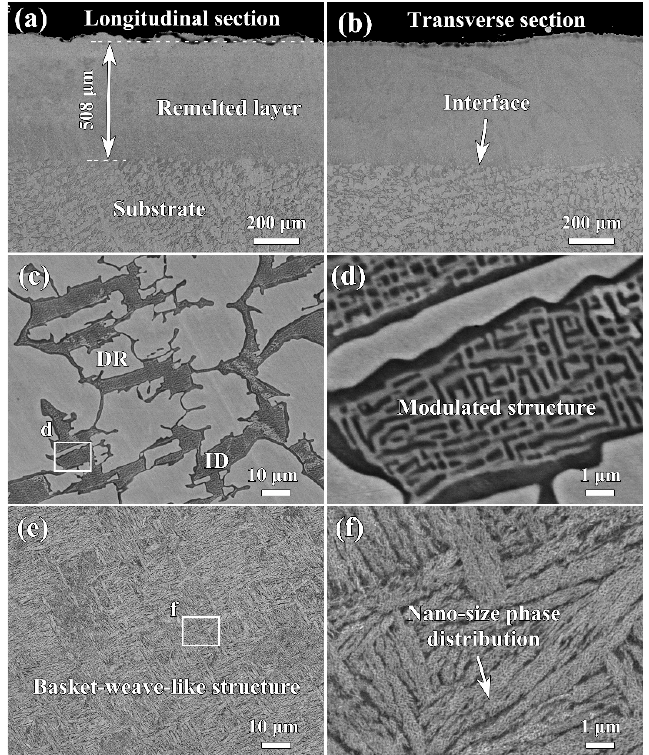
Figure 2. BSE micrographs of the Al 0.65 CoCrFeNi HEA after LR. ( a ) Transverse section; ( b ) longitudinal section; ( c , d ) substrate; and ( e , f ) remelted layer.